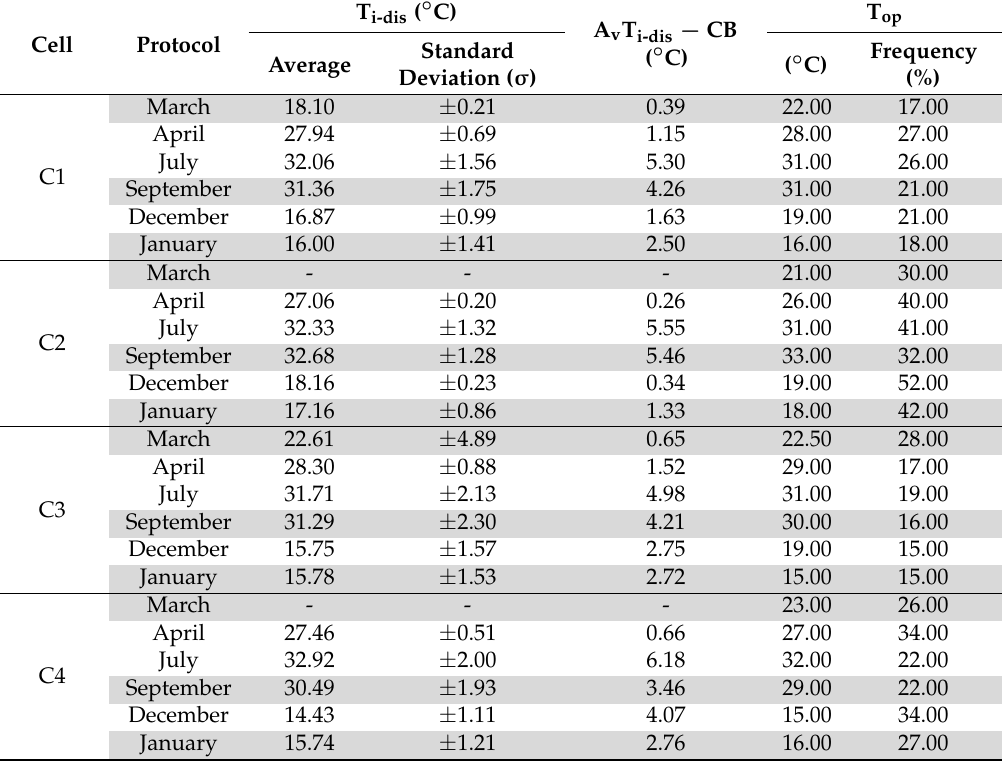
Table 6. Statistical temperature values (T i